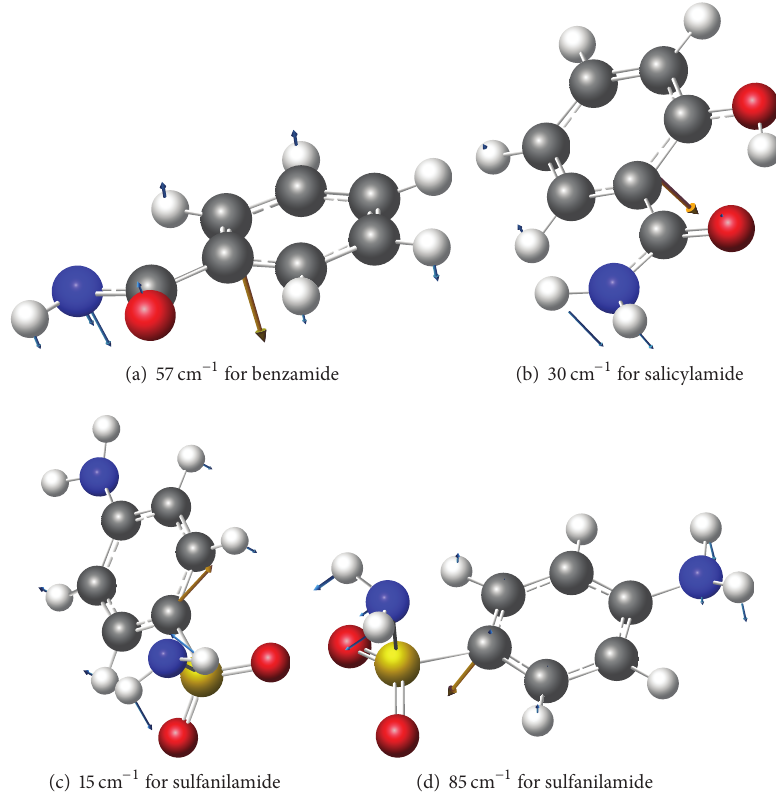
Figure 5: Low-frequency vibrational modes of the molecules below 100cm −1 . (a) 57 cm −1 for benzamide; (b) 30 cm −1 for salicylamide; (c) 15cm −1 for sulfanilamide; (d) 85 cm −1 for